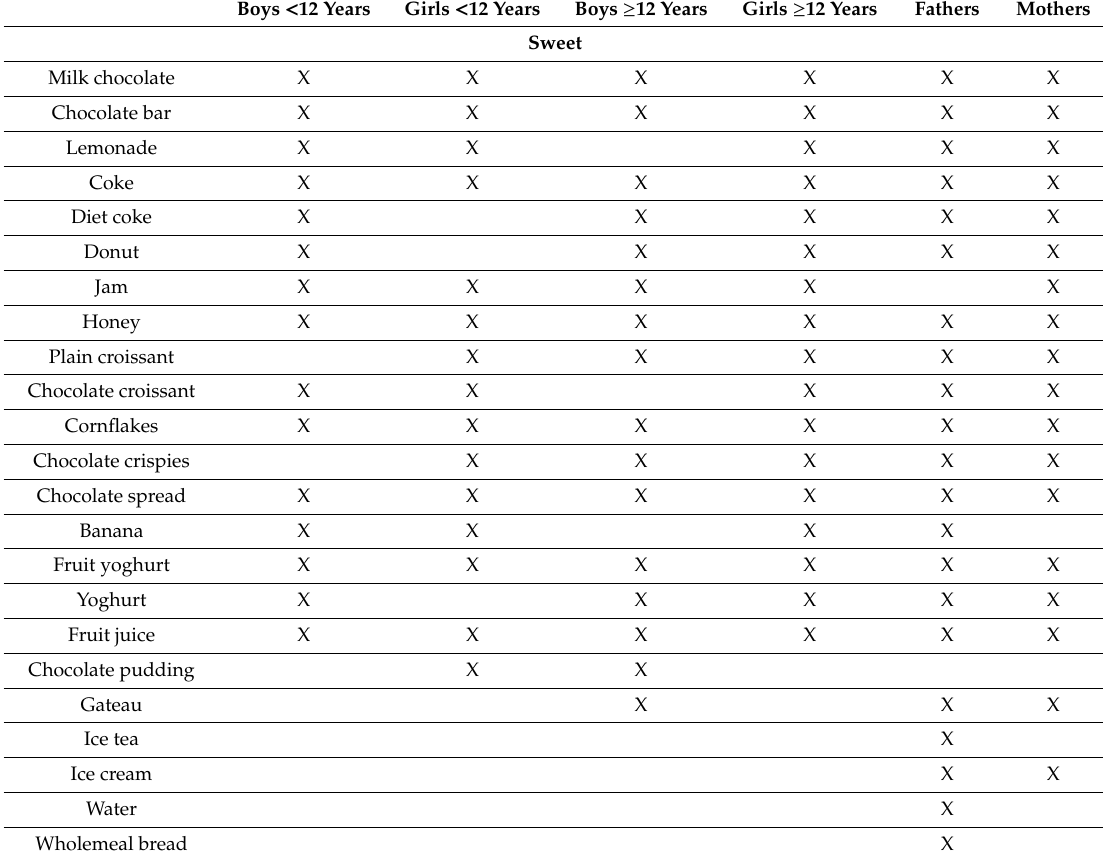
Table 1. Food and drinks representing the four taste modalities